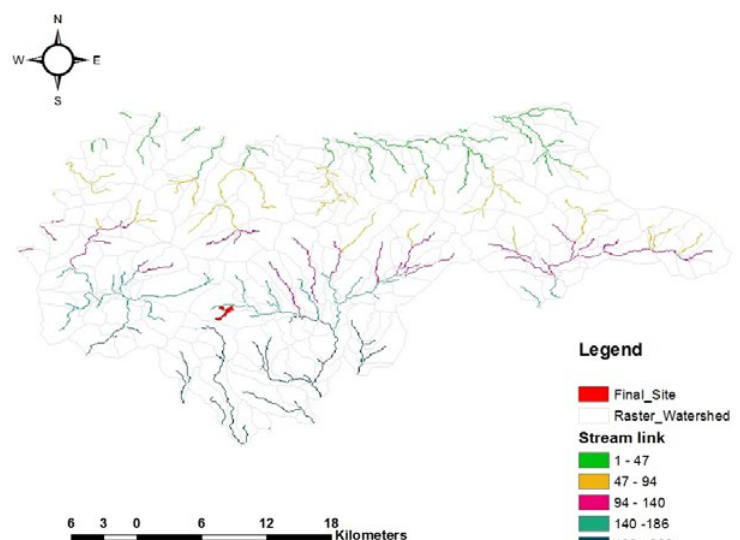
Fig. 9. Streams links for Fig. 9: Streams links for watershed